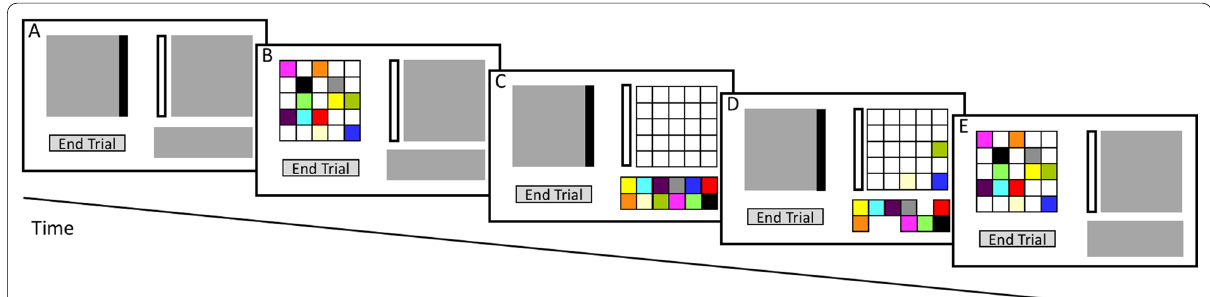
Fig. 2 Illustration of the pattern copy task. The task of the participants is to copy the pattern from the model window (upper left) to the workspace window (upper right) by dragging-and-dropping the corresponding squares from the resource window (lower right). When participants move the black slider to open the model window, the workspace and resource windows are covered by gray masks (B & E). When the participants touch the white bar opening in order to uncover the workspace and resource window, the model window is masked (C & D). Cognitive offloading is indicated by an increasing number of openings of the model